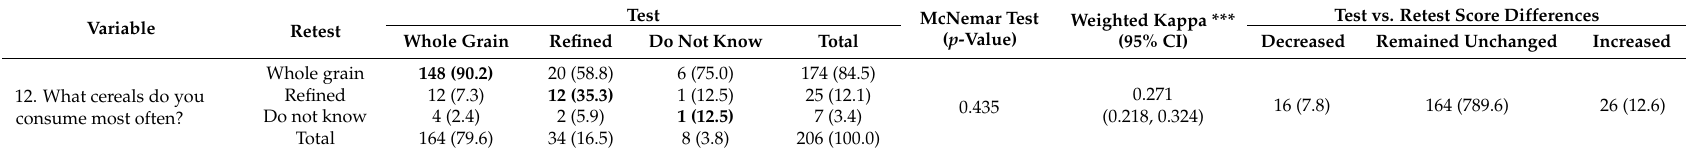
Table 6. Concordance for the question on cereals with three response options from the Mini-ECCA ( n = 206).